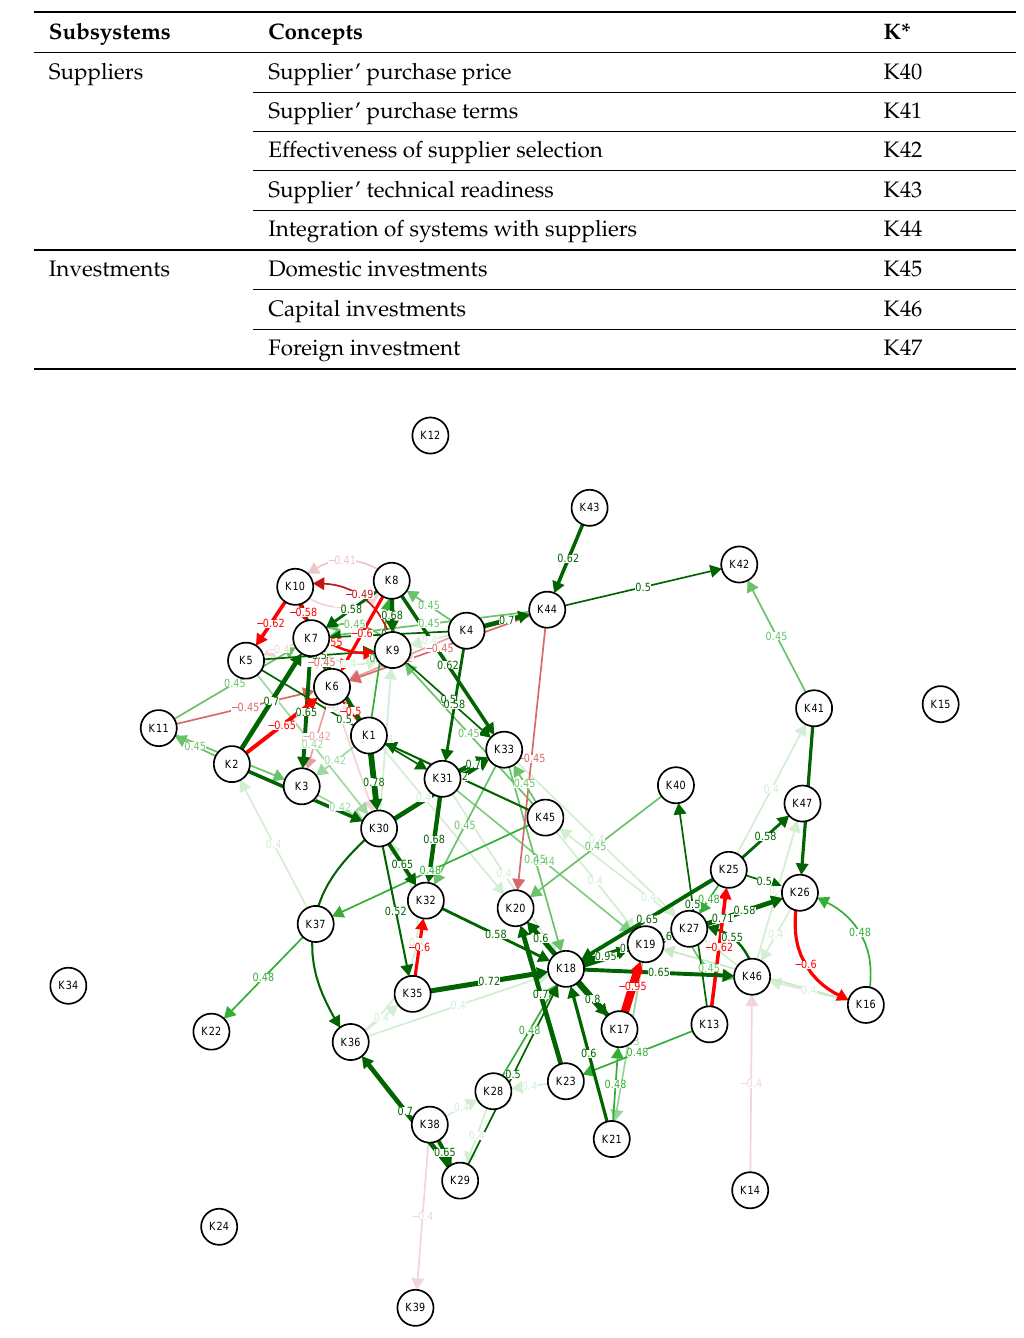
Figure 1. Fuzzy cognitive map of the retail system. Connections are only shown for absolute influences equal or greater than 0.4. Green arrows represent positive influences, while red arrows show negative influences. Thicker arrows imply stronger concept influences. Isolated concepts have absolute influences below